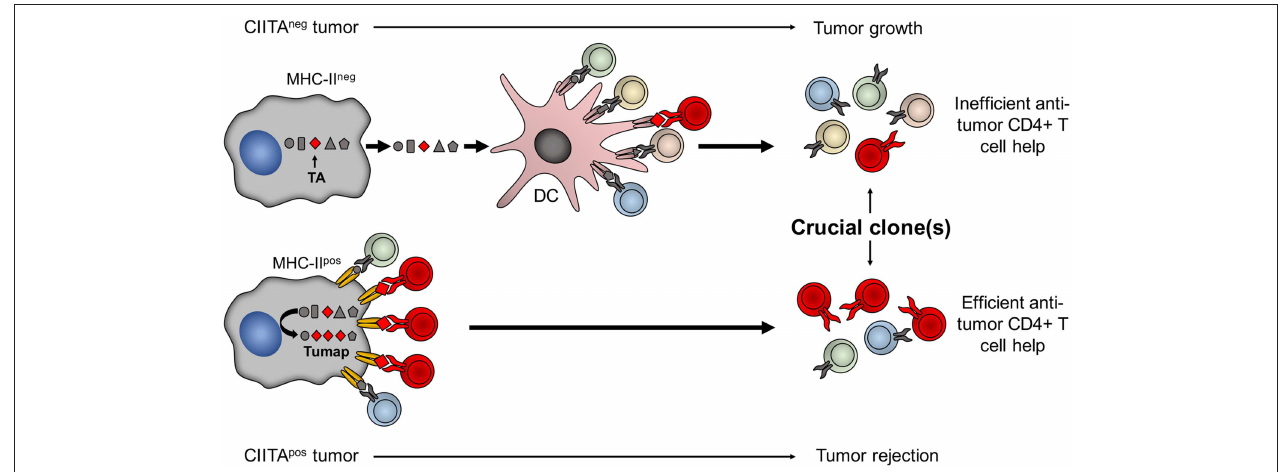
FIGURE 2 | Tumor cells expressing CIITA-driven MHC-II molecules are potent surrogate APC to prime relevant tumor-specific TH cells. The MHC class II-bound tumor peptidome (Tumap, red symbols) derived from CIITA-driven MHC-II expressing cells is highly enriched of tumor-specific epitopes (Lower part) as compared to the one of classical APC, such as dendritic cells (DC), that may capture tumor antigens (TA) only after phagocytosis of dying MHC-II-negative tumor cell debris (Upper part). As a result, in CIITA-tumors, MHC-II-tumor peptide complexes efficiently stimulate and amplify higher number of tumor-specific TH cell clones (in red) to generate a strong immune response capable to reject the tumor (Lower part). On the contrary, classical APC do not efficiently select sufficient tumor-specific peptides from MHC-II-negative tumor cells to be presented within the context of their MHC-II. As a consequence DC cannot efficiently prime tumor-specific TH cell clones and tumor takes off and grows (Upper